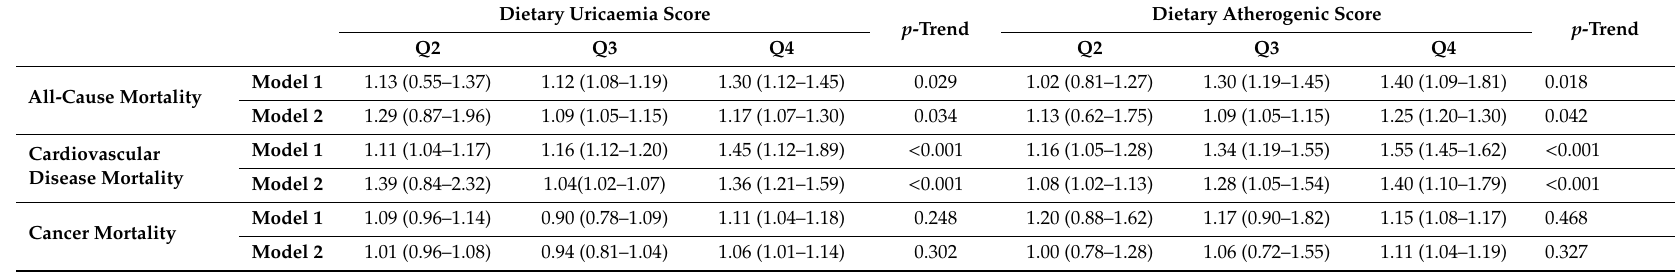
Table 2. Multivariable-adjusted hazard ratios (95% confidence intervals) for mortality across the Dietary Uricaemia Score (DUS) and the Dietary Atherogenic Score (DAS) quartiles